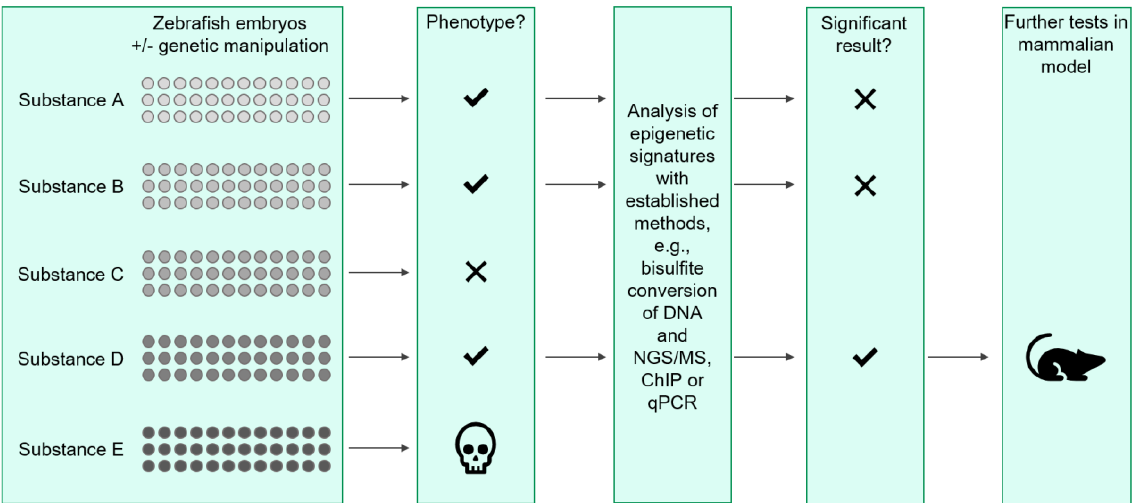
Figure 2. Schematic workflow for high throughput screening of different compounds in the zebrafish model. In a first step, zebrafish embryos with or without genetic manipulation via e.g., morpholino injection, are incubated in the presence of different substances (substances A to E in this example). The embryos are monitored to detect toxicity, developmental delay, and changes in phenotype. If the embryos develop phenotypically normal, fish are sacrificed and analyses of epi- genetic changes are conducted, e.g., with bisulfite conversion of DNA with subsequent next-generation sequencing (NGS) or mass spectrometry (MS). Further evaluations include chromatin immune precipitation (ChIP) and quantitative PCR (qPCR). If significant results regarding the effect of the specific substance are obtained, the substance is tested further in a mammalian, e.g., murine, model.